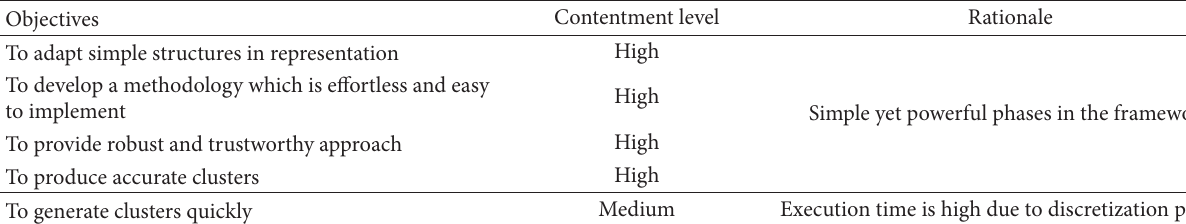
Algorithm 3: 𝐾 -means clustering. Table 4: Objective